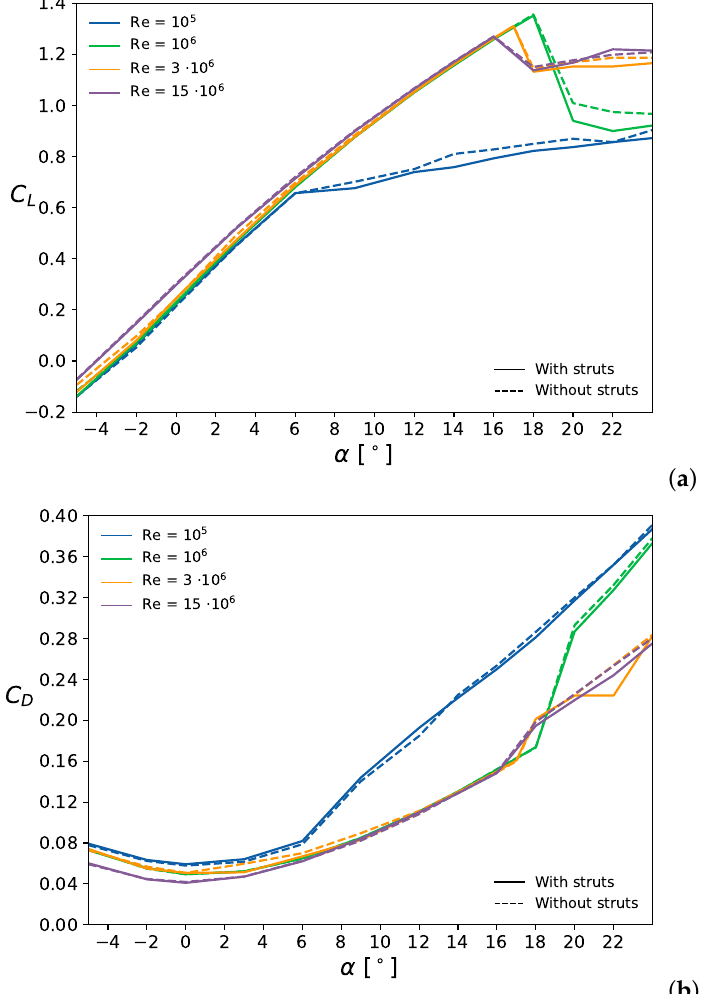
Figure 11. Aerodynamic force coefficients as functions of the angle of attack, without side-slip: ( a ) lift coefficient C L and ( b ) drag coefficient C D